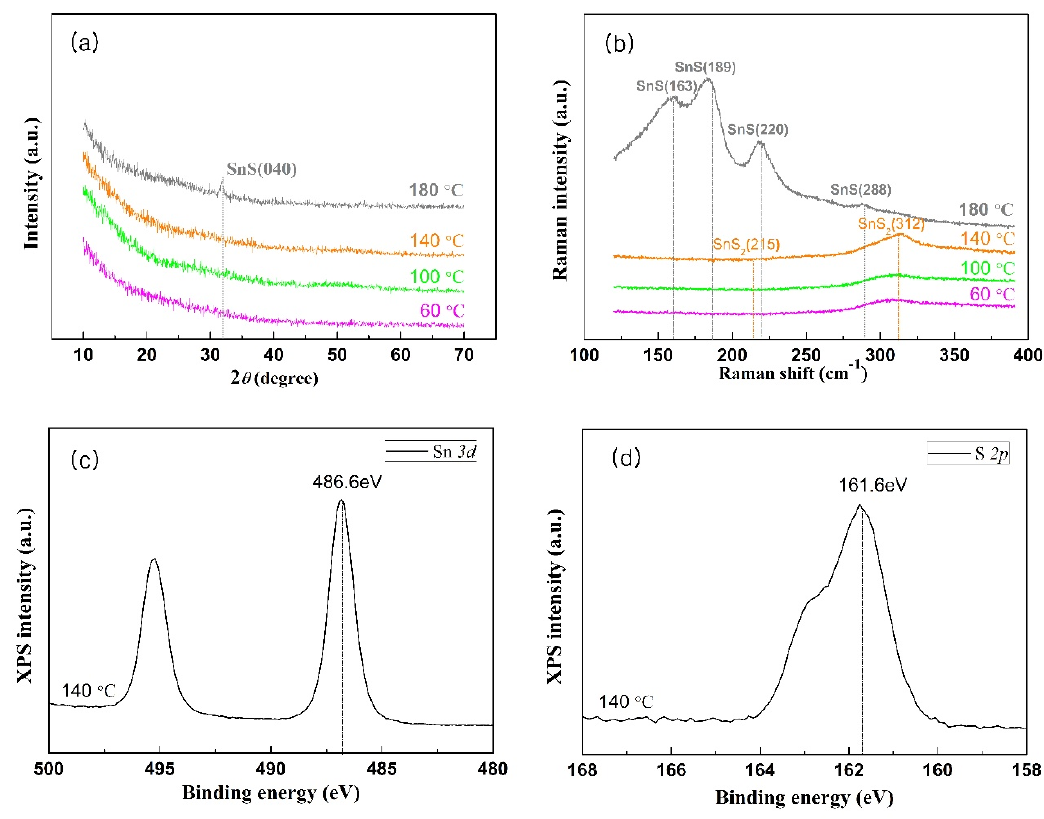
Figure 3. ( a ) XRD patterns of the Sn x S y films deposited at 60, 100, 140, and 180 ◦ C on the glass substrate. The crystal structures of the Sn x S y films below 140 ◦ C were amorphous, while at 180 ◦ C they transformed into orthorhombic SnS with the preferred crystal orientation along the (040) plane. ( b ) Raman spectra of the Sn x S y films grown at 60, 100, 140, and 180 ◦ C on the glass substrate. The Sn x S y films consisted of SnS 2 at 60, 100, and 140 ◦ C, while at 180 ◦ C they transformed into SnS. X-ray photoelectron spectroscopy (XPS) of ( c ) Sn 3 d and ( d ) S 2 p peaks of the SnS 2 film grown at 140 ◦ C on the silicon wafer.